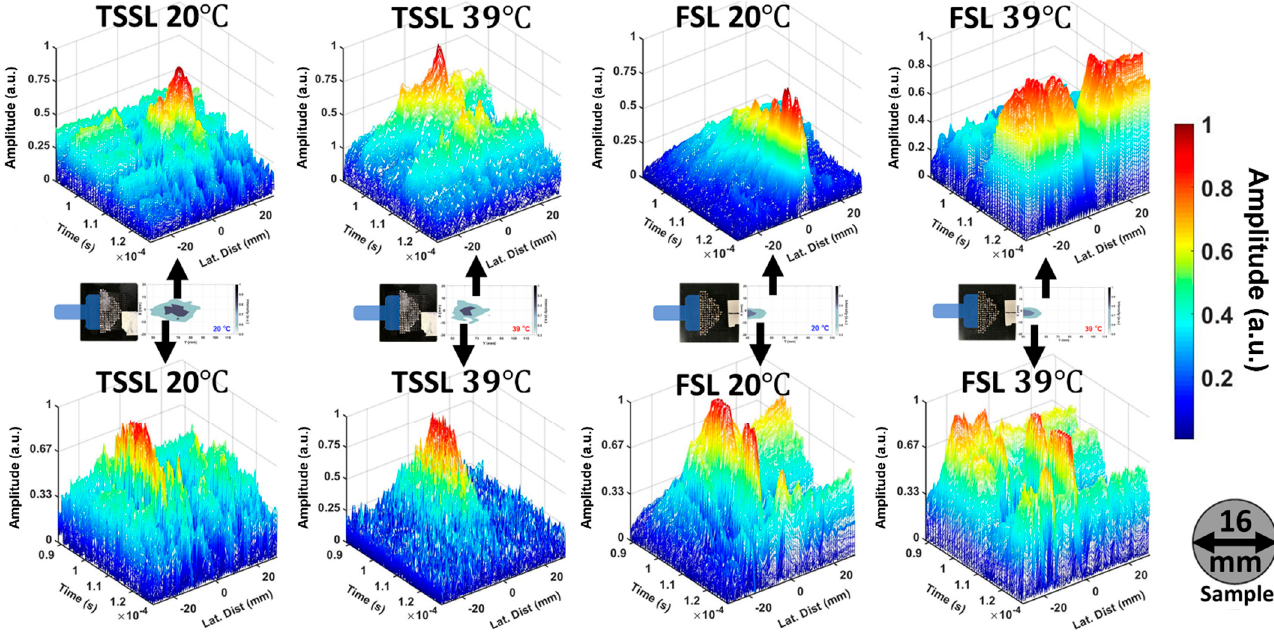
Figure 5. One-dimensional temporal domain time-of-flight mapping. A 16 mm diameter Aluminum rod translated on lateral direction ( Y -axis) by a distance of 60 mm with 1 mm interval. The translating axis on X -axis was located 70 mm away from the transducer surface (Upper four subfigures ( A , B , E , F )) and 60 mm away from the transducer surface (Lower four subfigures ( C , D , G , H )).